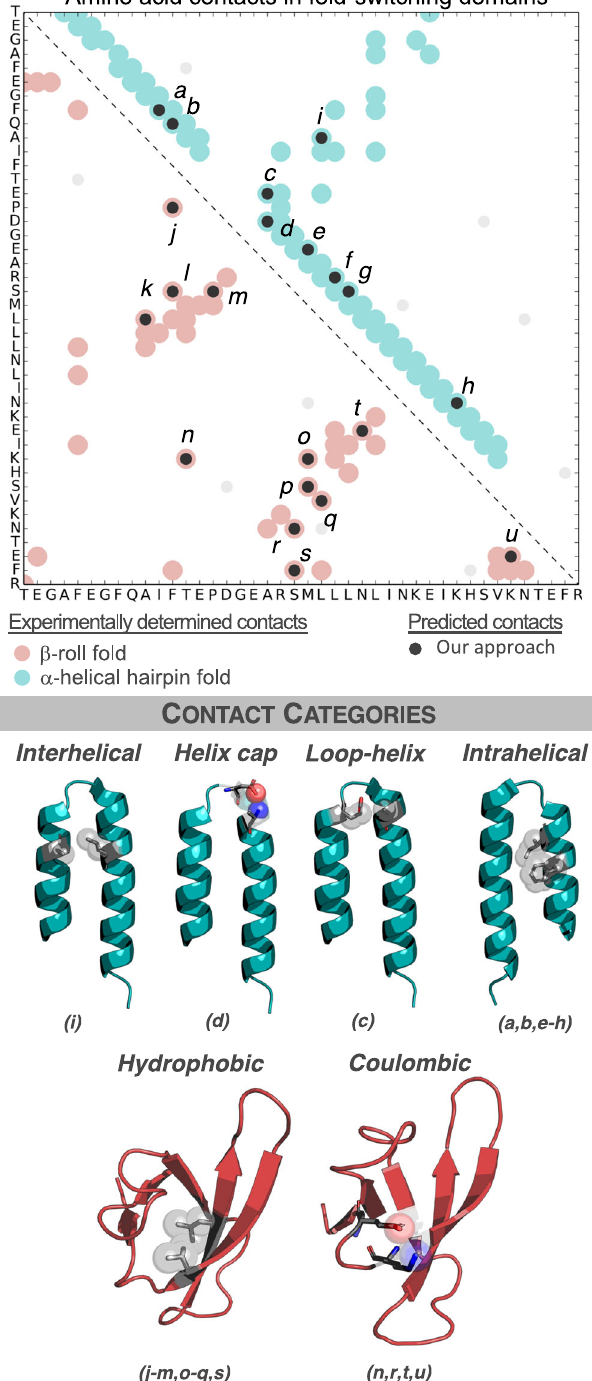
Fig. 3 Fold-switching sequences have conserved amino acid contacts from both folds. Predicted amino acid contacts from fold-switching sequences (dark gray circles) correspond to both the β -roll fold (PDB ID: 2LCL, red circles) and the α -helical hairpin fold (PDB ID: 5OND, chain A, teal circles). Couplings that do not correspond to experimentally observed contacts are shown as light circles. Categories of amino acid contacts from both folds use the alphabetically labeled contacts in the plot above them. Source data are provided as a Source Data fi the GREMLIN algorithm — was responsible for the discovery of re fl ect folding properties of the NusG superfamily, whose members alternative contacts. These results again indicate that shallower largely do not switch folds. alignments — such as the JPred- fi ltered one (N eff = 834) — re fl ect This analysis of putative fold-switching CTDs indicates folding properties of the RfaH subfamily while deeper alignments evolutionary coupling of residue-residue contacts unique to two (N eff = 9633 and 17,245 for Robetta and EVCouplings, respectively), distinct folds. For the α -helical fold, six intrahelical hydrophobic